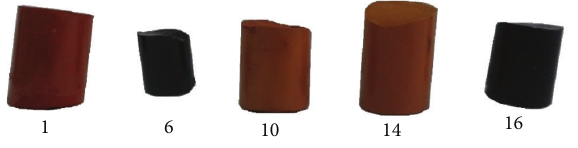
Figure 8: DO design samples photos.